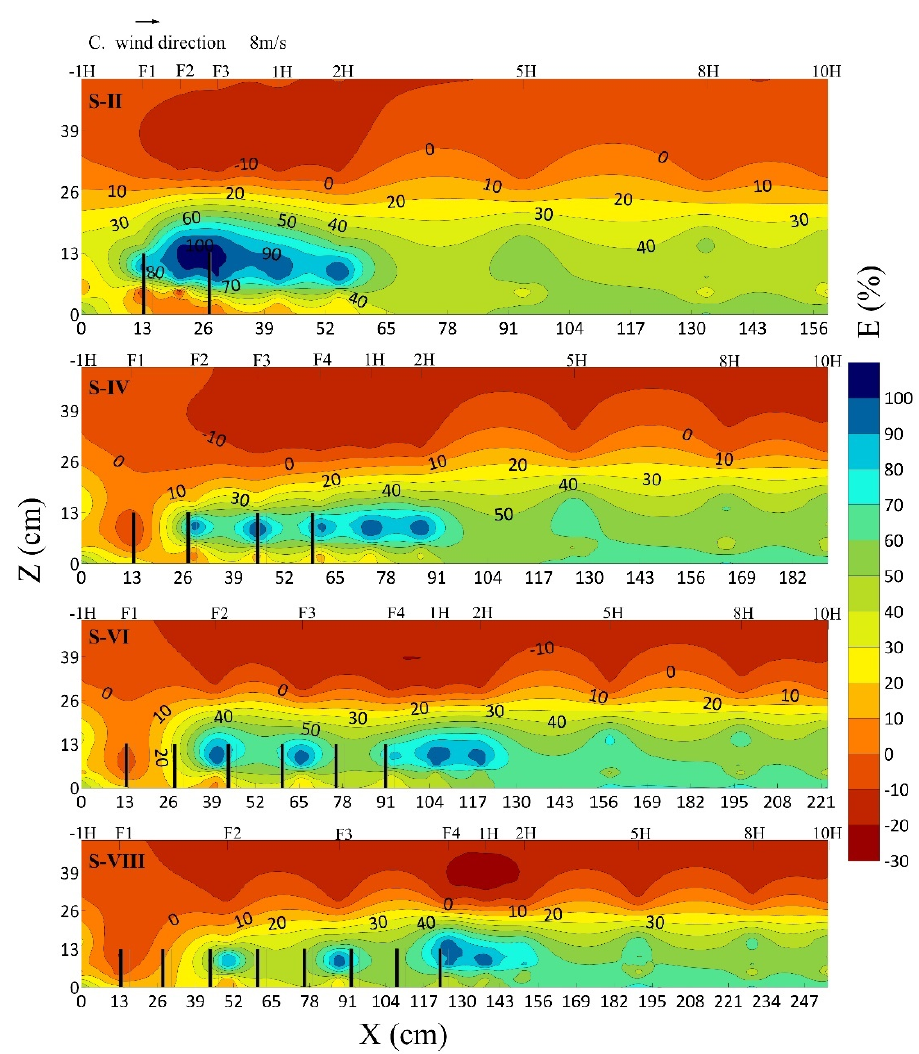
Figure 6. Contour map of the distribution of the shelter efficiency of single shelterbelts with different rows. The abscissa represents the downwind distance (cm) and the ordinate represents the vertical height (cm). The top abscissa represents the observation point. 8 m·s − 1 . The legend indicates the shelter efficiency.